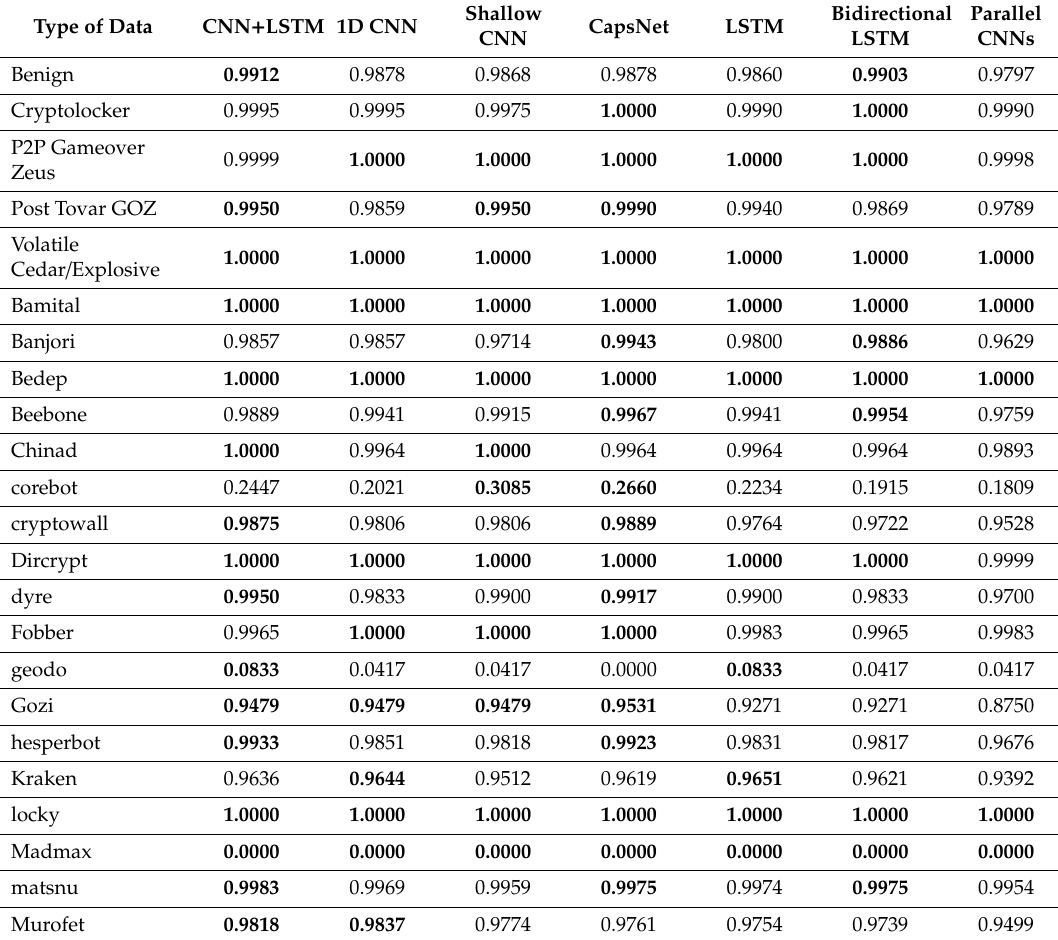
Table 6. Accuracy of time split experiment with the test dataset for benign and DGA